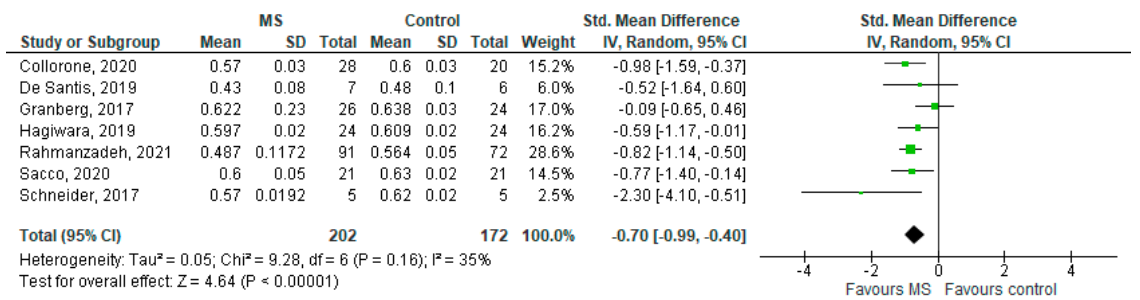
Figure 4. Forest plot for the standardized mean difference of the NDI in NAWM (MS vs. control) [20,23–27,29]. Abbreviations: SD = standard deviation; CI = confidence interval; NDI = Neurite Density Index; MS = multiple sclerosis;